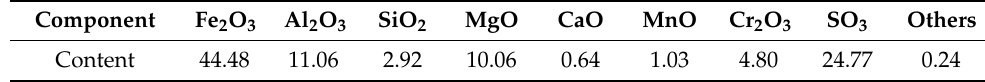
Table 8. Elemental composition of impurity removal residue